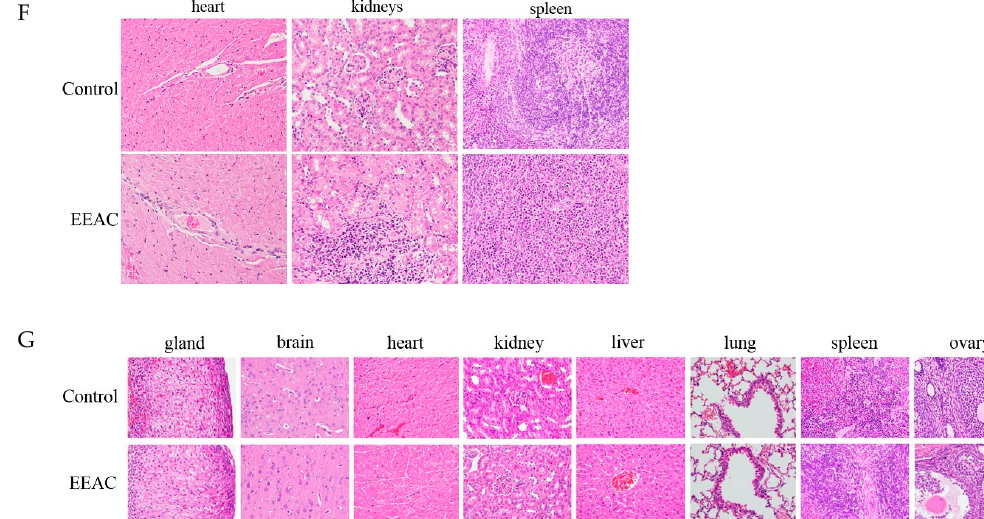
Figure 5. Anti-tumor effect of EEAC on tumor growth in vivo animal model. Tumor-bearing nude mice were treated with DMSO or EEAC (100 μ g/g) for 87 days (each group contained five mice). ( A ) Photo of tumors (left) and the histogram results of tumor weights (right). ( B ) Tumor volumes were measured every other day. ( C ) Effect of EEAC on the increase of tumor volume. ( D ) Nude mice body weights were measured every other day. ( E ) Chemical plasma profiles were determined with FUJIFILM colorimetric analyzer (DRI-Chem 3000). ( F and G ) Tissue sections from nude mice organs were stained with hematoxylin and eosin (400×). All the results are presented as mean ± SD, ** p < 0.01;